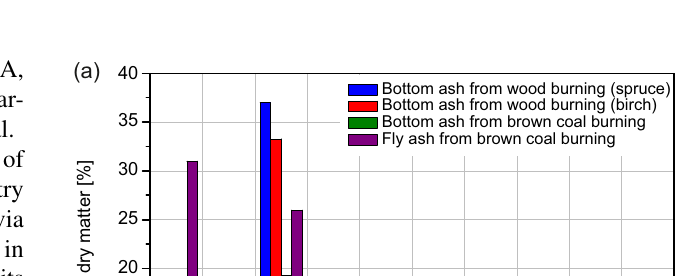
Table 2. Sample overview with temperature range in which ice nucleation (IN) was observed. Combustion Dry generation Wet generation + US Wet generation − US Ash type material IN observed T range IN observed T range IN observed T range Bottom ash Wood (spruce) ≤− 35 ◦ C ≤− 34 ◦ C – Wood (birch) ≤− 35 ◦ C – – Wood (beech) ≤− 35 ◦ C – – Brown coal ≤− 32 ◦ C ≤− 35 ◦ C – Fly ash Brown coal ≤− 27 ◦ C ≤− 24 ◦ C ≤− 34 ◦ C